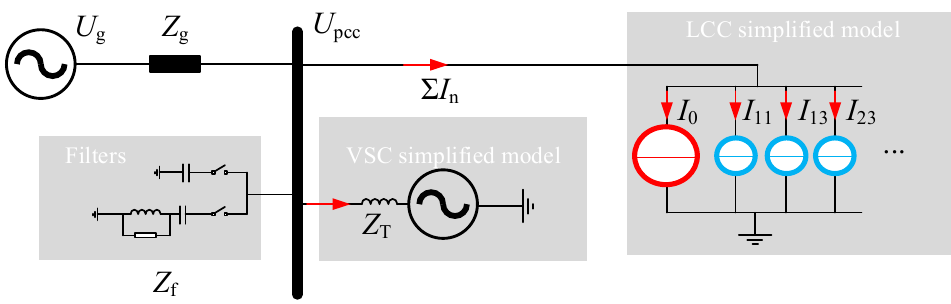
Figure 13. Serial LCC-VSC hybrid HVdc simplified model with ac system connection.